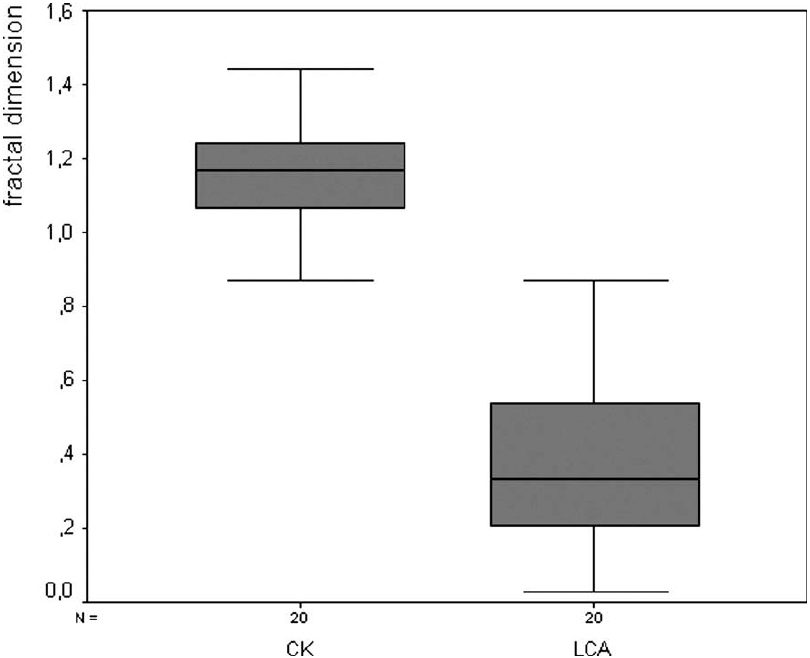
Fig. 7. Boxplot of the fractal dimension of immunopositive tissue elements found in CK and LCA stained sections ( t -test: p < 0 .